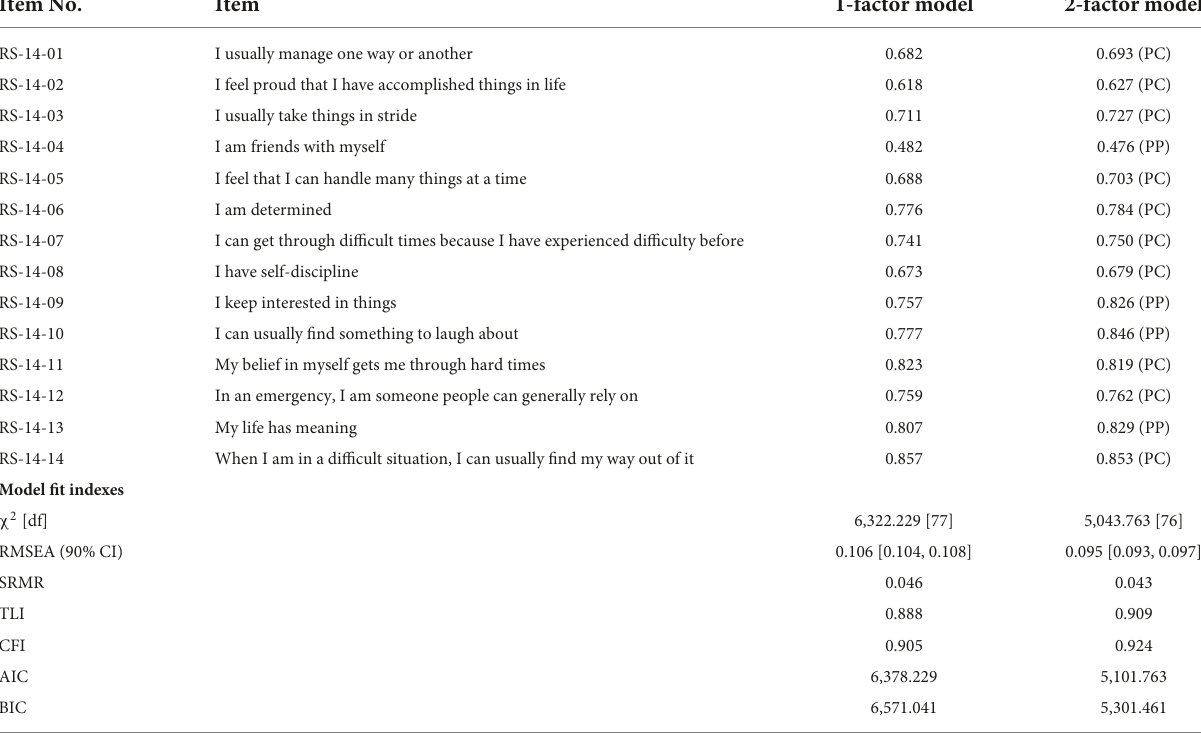
TABLE 1 RS-14 items, standardized factor loadings, and model fit indexes ( n = 7,231). Item